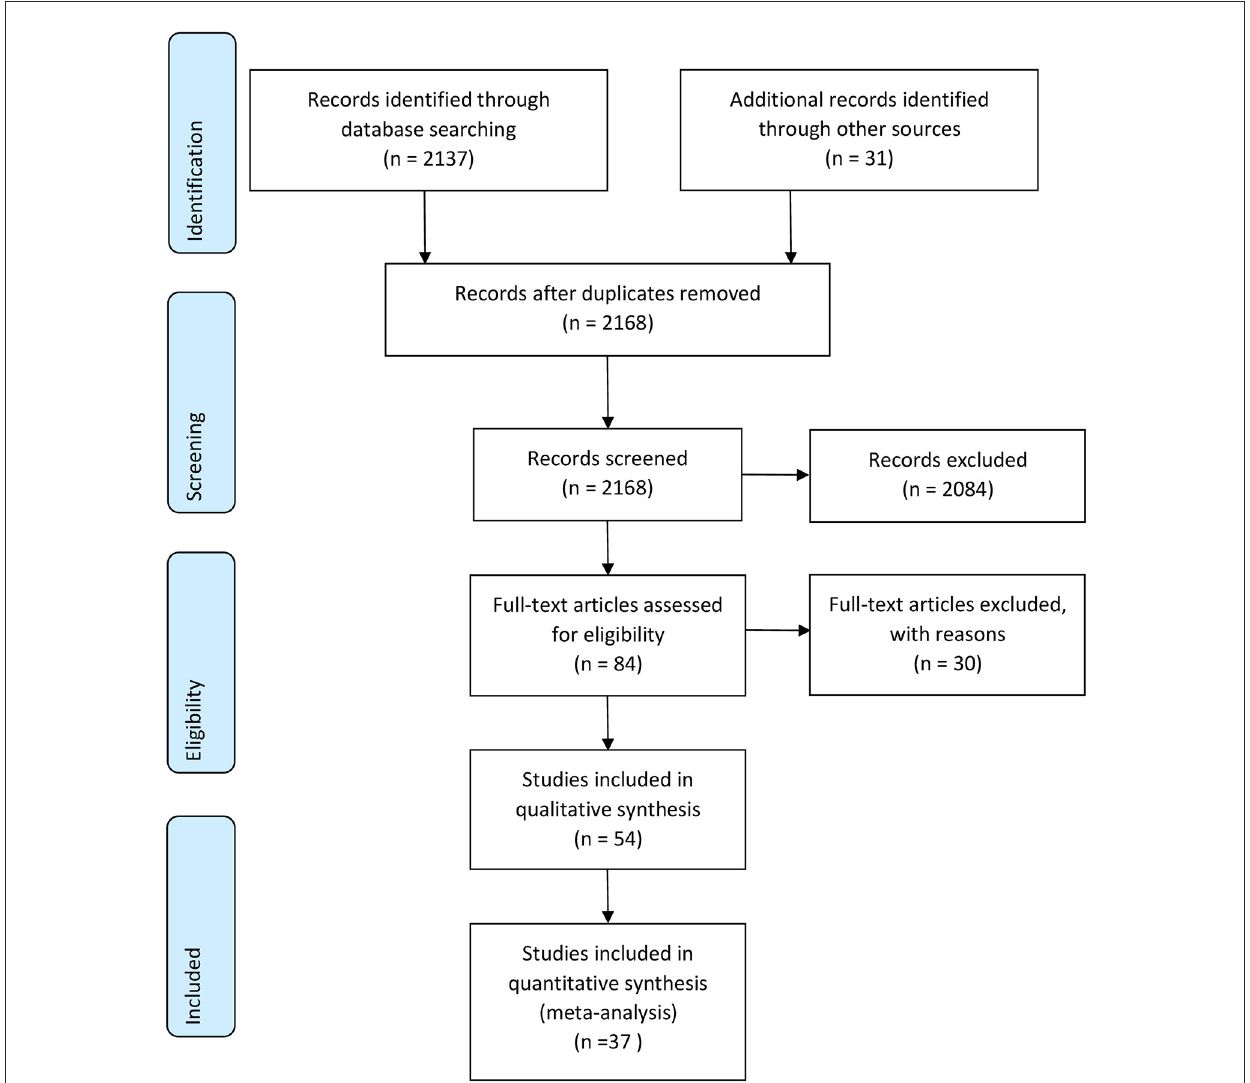
FIGURE1 PRISMA flow chart of the systematic review. From initial 2168, fifty-four studies were later included in the qualitative synthesis. Finally, 37 studies were evaluated statistically in the meta-analysis (quantitative analysis).